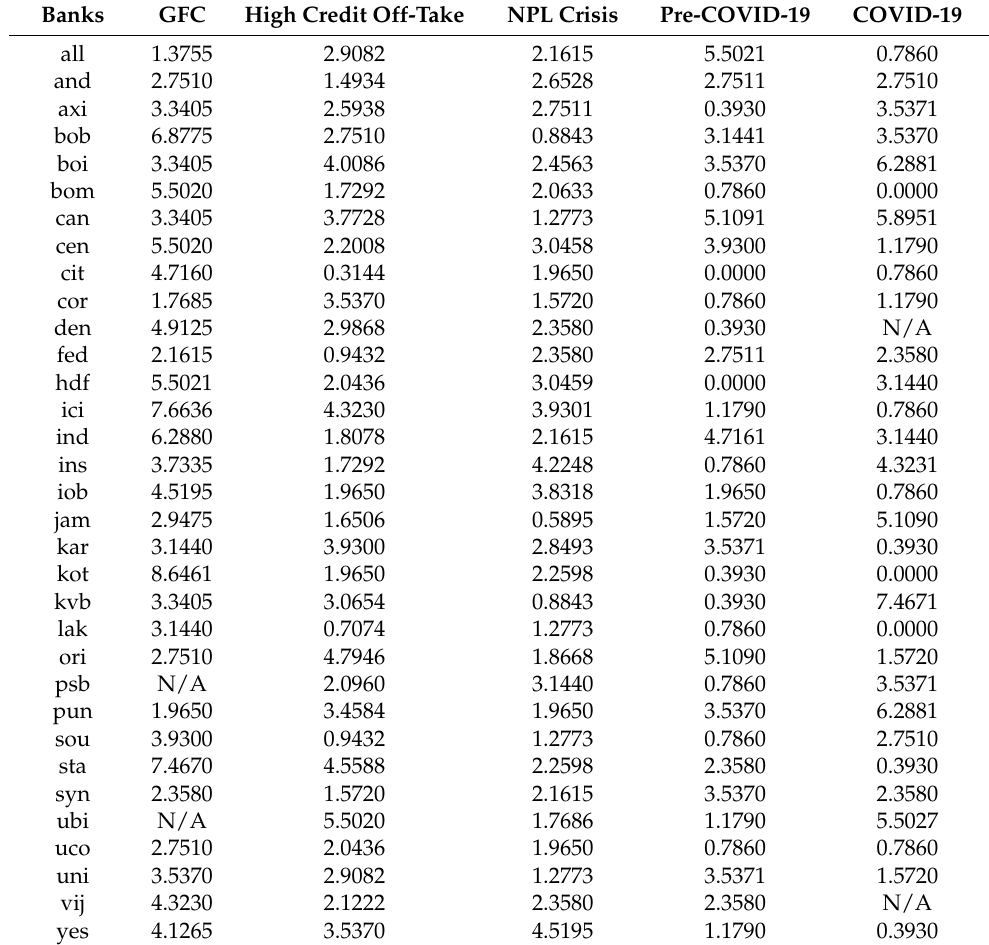
Table A2. Bank-wise average Market Power Network Index (MPNI) for five distinct economic phases.